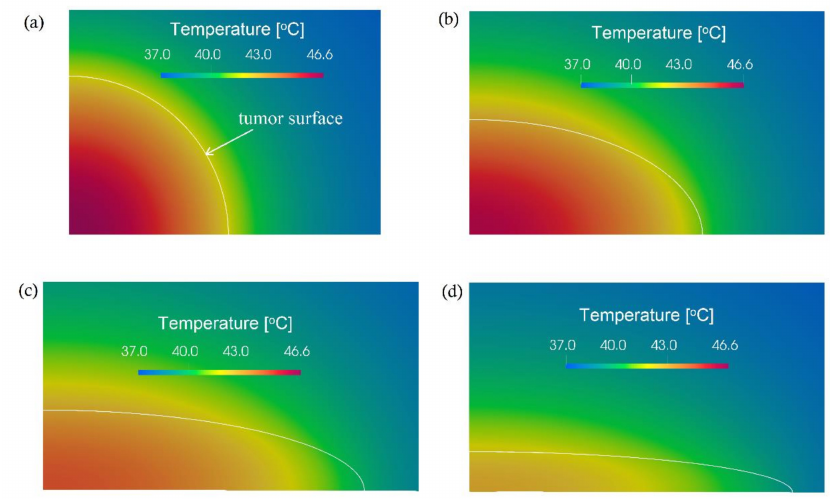
Figure 5. Treatment temperature field after 22 min of heating for oblate spheroidal tumor shapes with different aspect ratios. ( a ) AR = 1, ( b ) AR = 2, ( c ) AR = 4 and ( d ) AR =